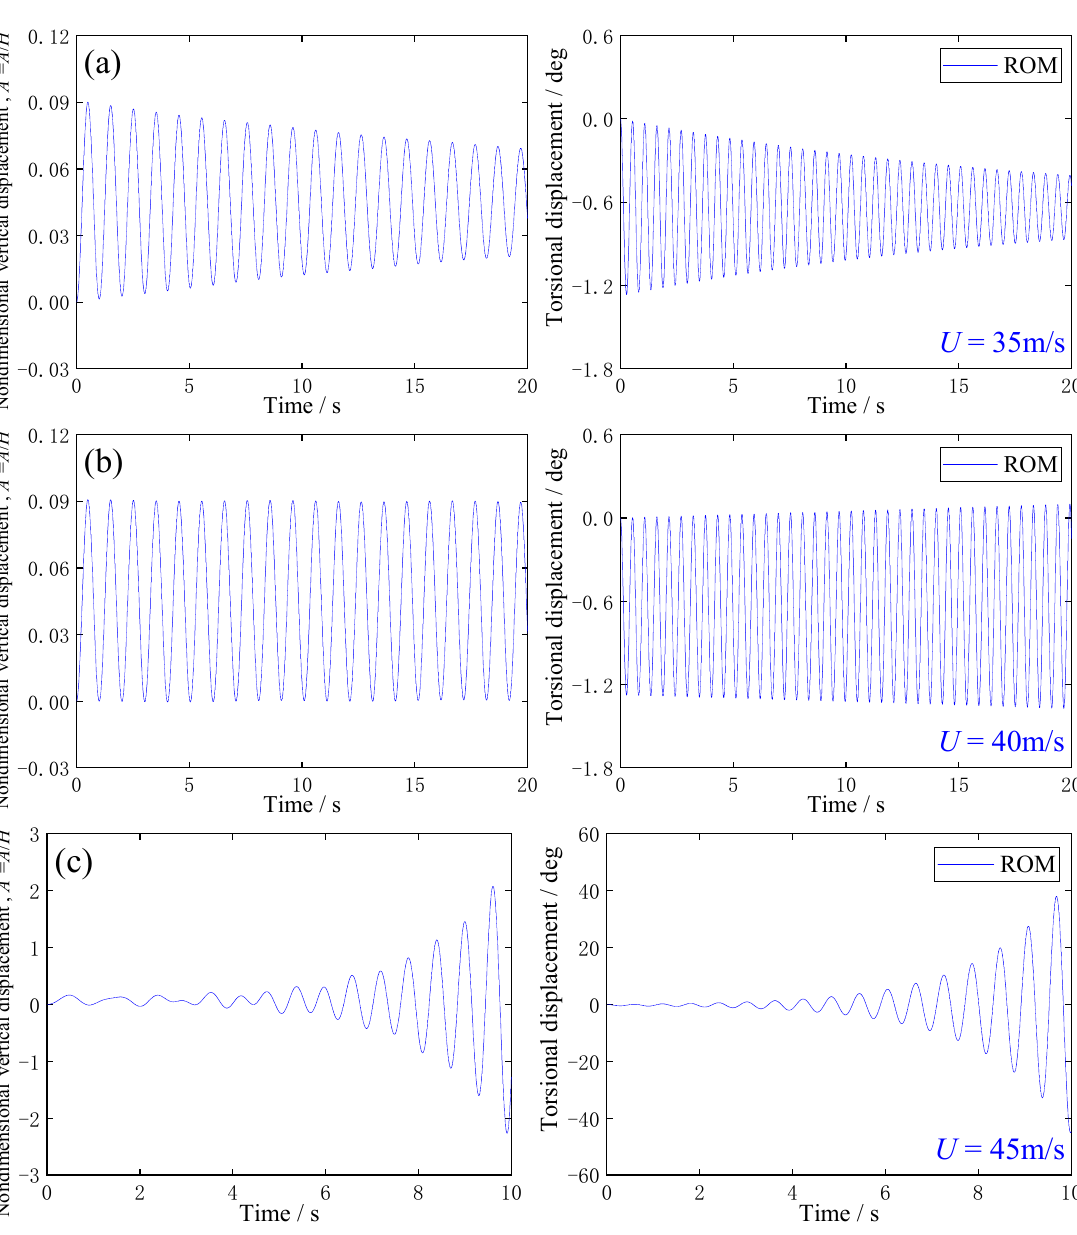
12 of 18 Figure 9. Vertical and torsional displacements of main deck section of GBEB, based on the FSI method for incoming wind speeds of ( a ) 35 m/s, ( b ) 40 m/s, and ( c ) 45 m/s for the prototype bridge, respectively. The structural dynamic parameters of the main girder of the GBEB in Table 3 are applied to the FSI program, based on the Volterra model and Newmark- β method. It should be noted that the first-order kernel function of the Volterra series of the aerodynamic force of the main deck section model is identified for the wind speed of 5